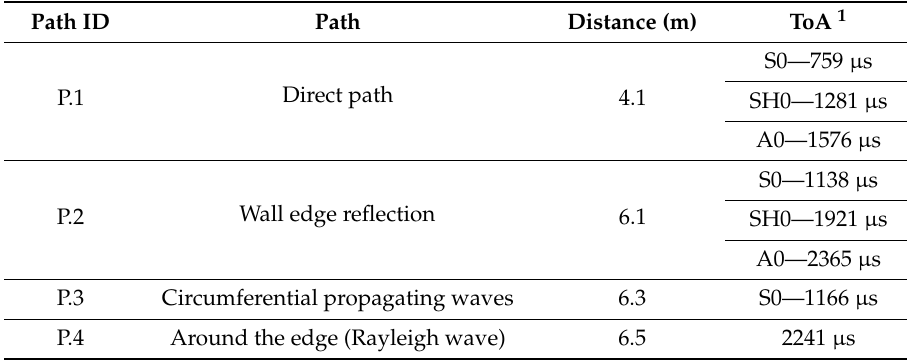
Table 1. Wave paths and analytical Time-of-Arrival (ToA) of potential signals for wave excitation on the tank